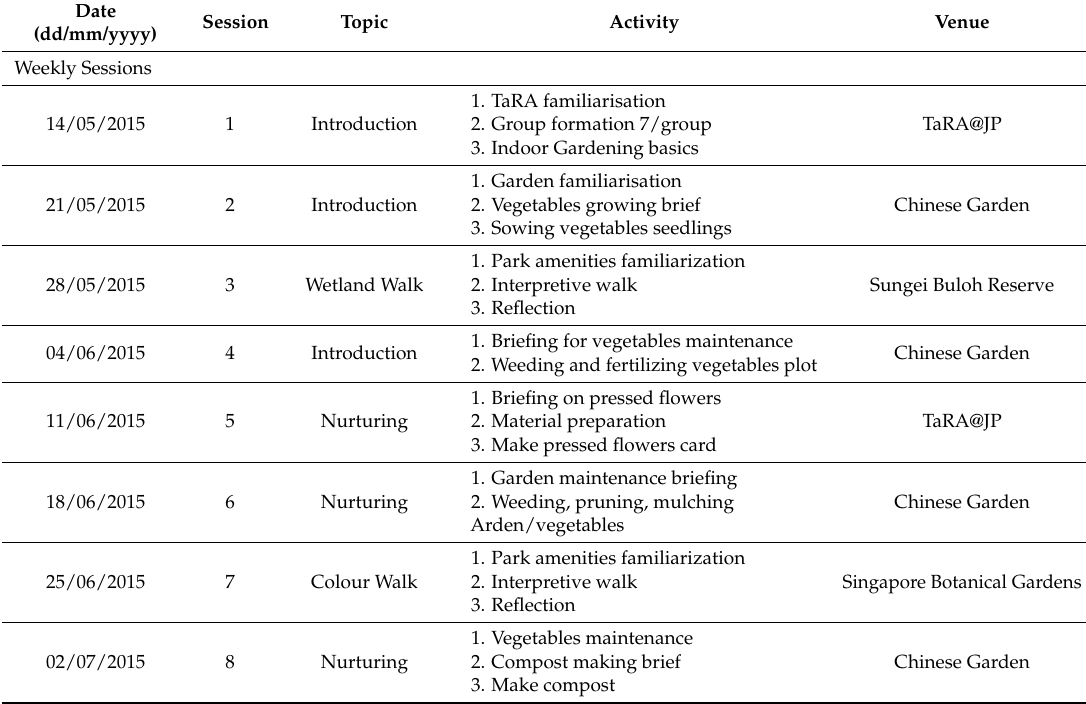
Table 1. Protocols for horticultural therapy (HT) intervention